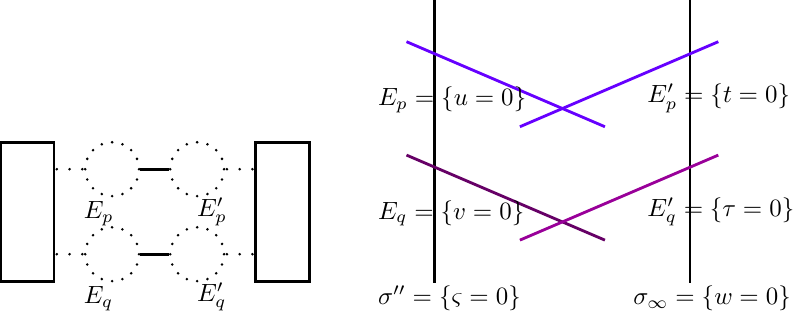
Figure 6. Blowing up two distinct instanton points give rise to double copy of E-string pairs, connected at di(cid:11)erent points of